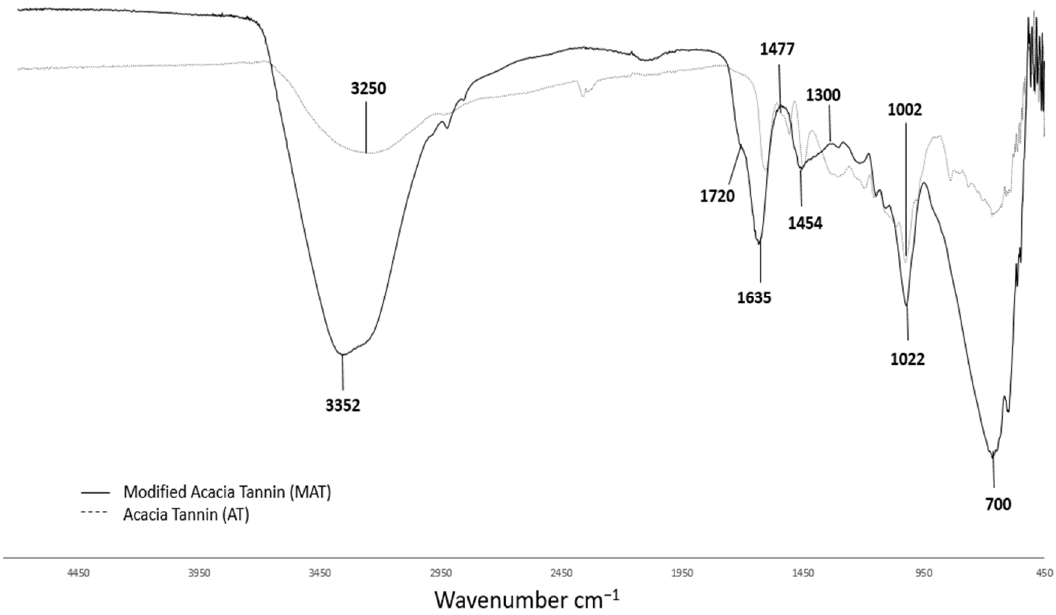
Figure 2. The spectra of Acacia tannin (AT) and the modified Acacia tannin (MAT) .